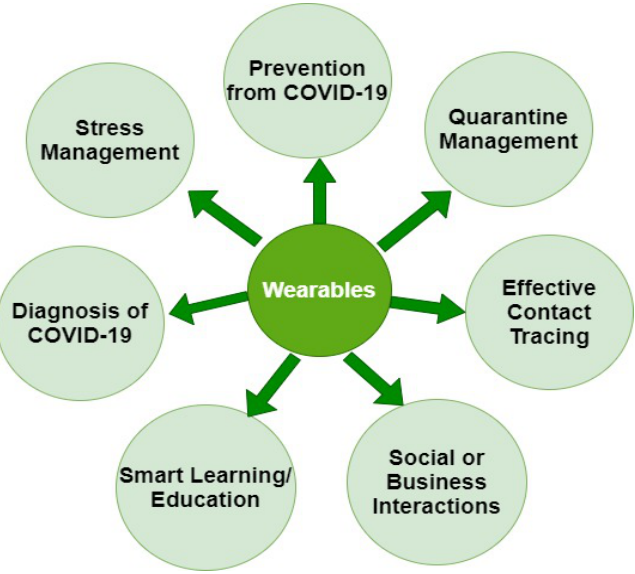
Figure 4. Potential applications of wearables in the COVID-19